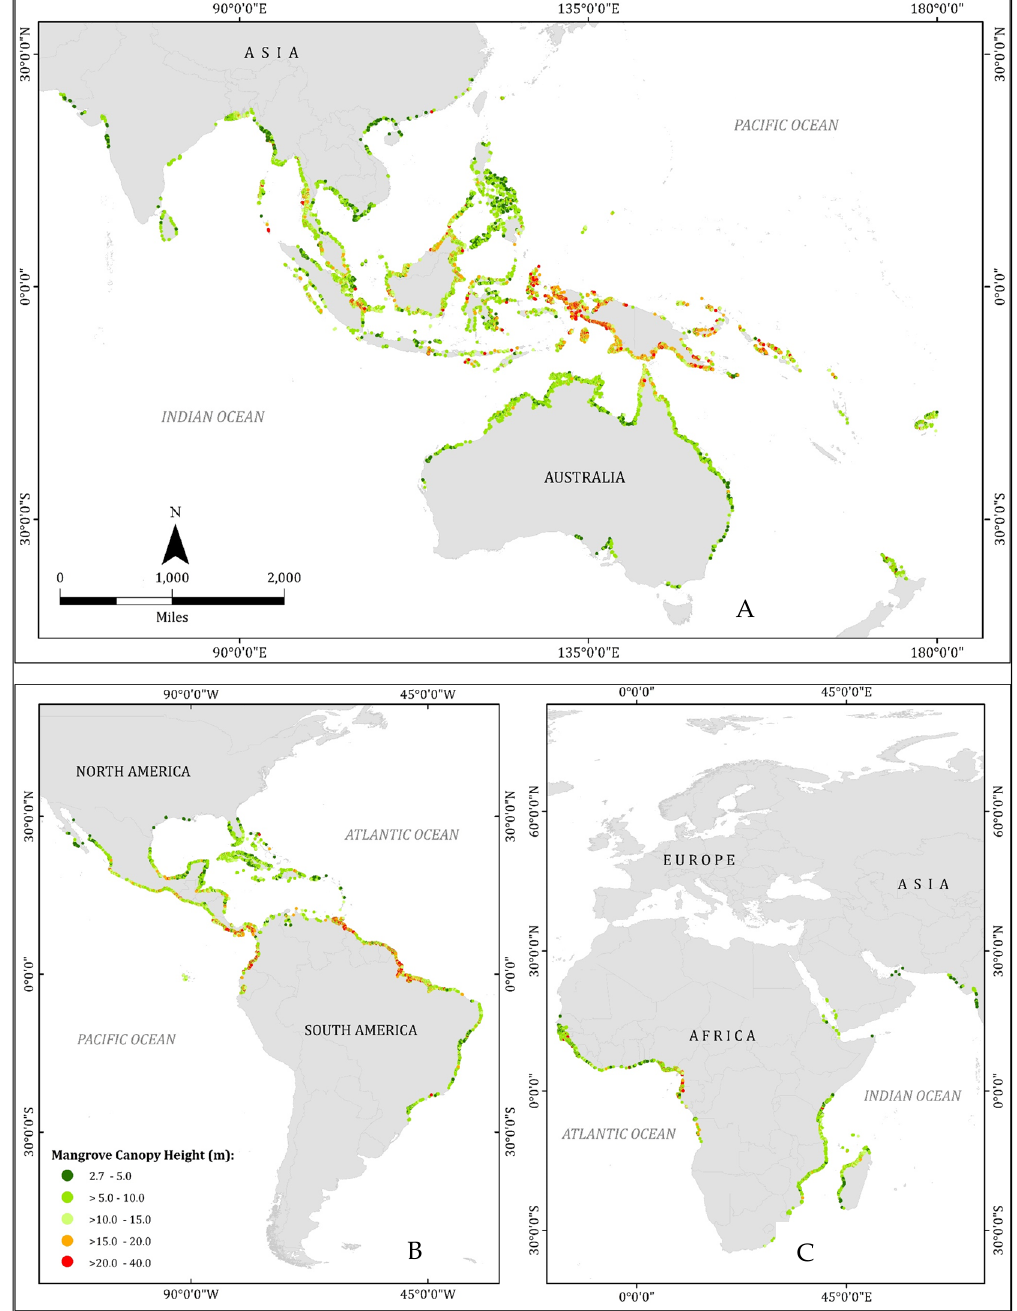
Figure 2. Global mangrove canopy height map at 30 m pixel size. For clarity of display, global mangrove areas were resampled from the original 30 m SRTM pixel to 0.1° grid and shown in three different panels. ( A ) Asia and Australia; ( B ) Americas; and ( C ) Africa and southwest Asia. The latitudinal distribution of mangrove heights and the areas occupied by each height class are shown in Figure 3. For clarity of display, the latitudes are binned at 1° and the heights are binned at 1 m (Figure 3a). Results indicated that the tallest mangroves were present near the equator and that the maximum height of mangroves declined in both hemispheres as the distance from the equator increased. In the Northern Hemisphere, 5– 17 m tall mangroves occupied relatively large areas between 4°–13° N latitude and 22° N latitude. In the Southern Hemisphere, a large area of mangroves existed between 1°–3° S